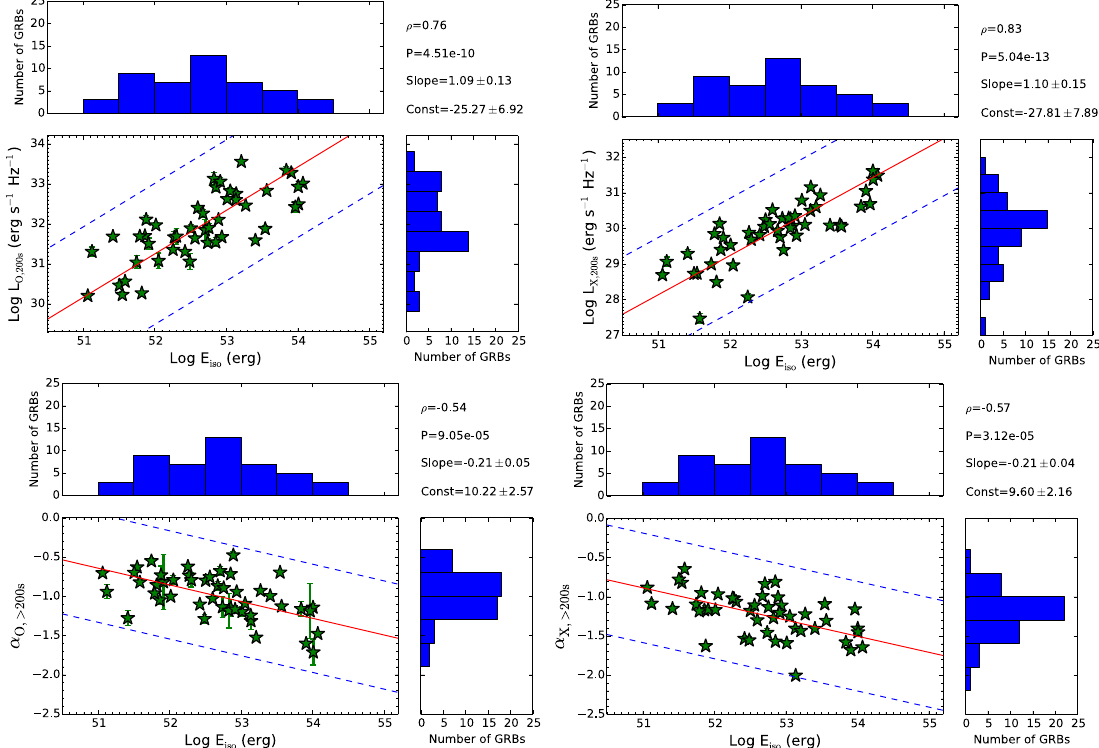
Figure 3. Top Left: The optical luminosity at rest frame 200s versus isotropic energy. Top Right: The X-ray luminosity at rest frame 200s versus isotropic energy. Bottom Left: The optical average decay index determined from rest frame 200s versus isotropic energy. Bottom Right: The X-ray average decay index determined from rest frame 200s versus isotropic energy. In all panels, the red solid line represents the best fit regression and the blue dashed line represents the 3 σ deviation. In the top right corner of each panel, we give the Spearman rank coefficient, ρ , and corresponding null hypothesis probability, P, and we provide the best fit slope and constant determined by linear regression (Figure is a reproduction of Figure 2 from [3]).